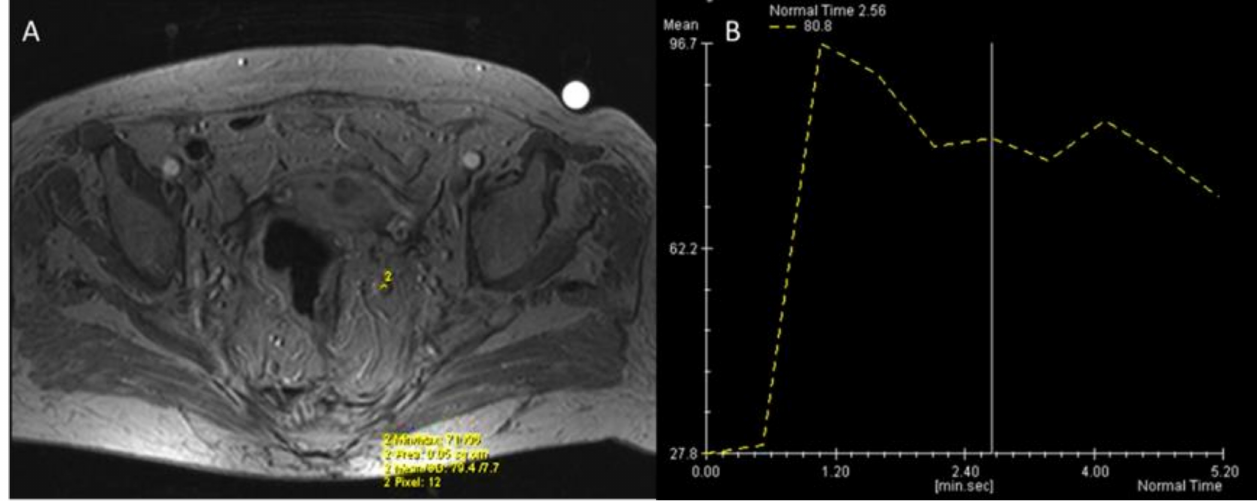
Figure 7. Man 72 y.o. with rectal cancer (same patient as in Figures 3 and 5). DCE- MRI ( A ) nodal assessment with Intensity/Time curve evaluation ( B